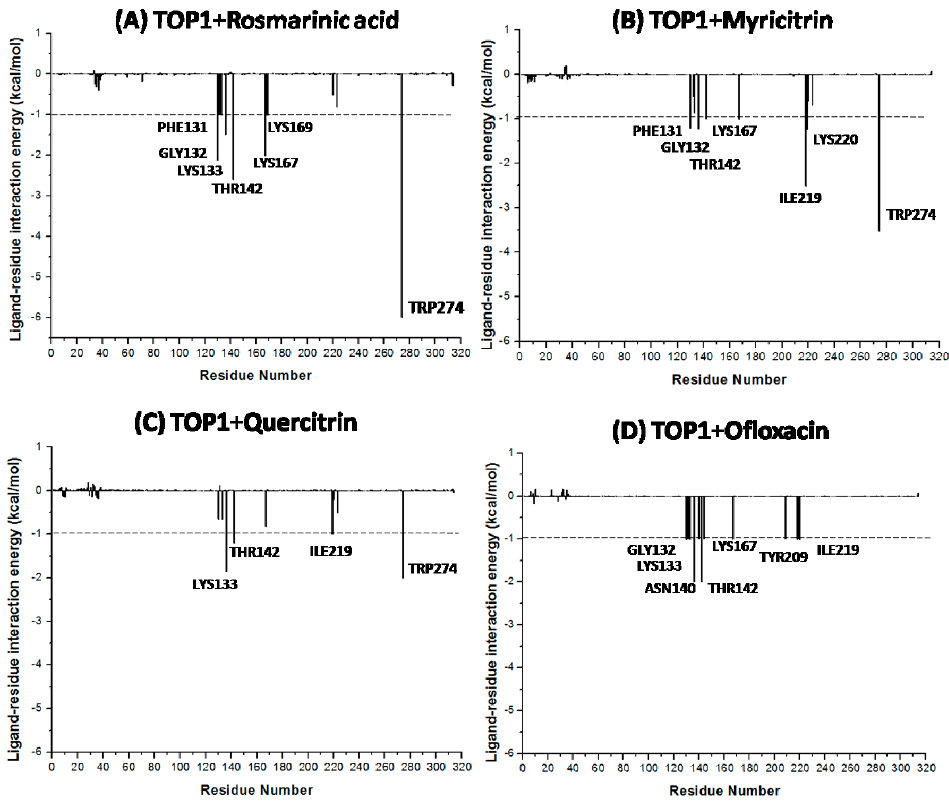
Figure 5. Decomposition of MM/PBSA into contributions from individual residues for ( A ) TOP1+Rosmarinic acid; ( B ) TOP1+Myricitrin; ( C ) TOP1+Quercitrin; ( D ) TOP1+Ofloxacin.